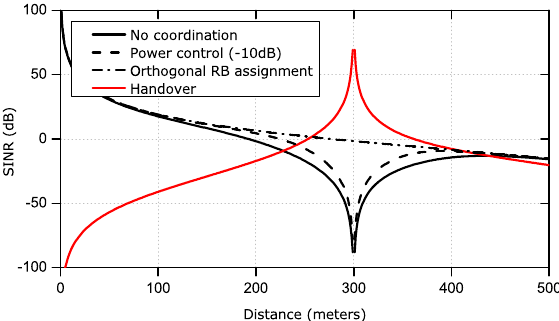
Figure 1. Achieved downlink (DL) signal-to-interference and noise ratio (SINR) of a macrocell user for different solutions in a three-tier hexagonal cellular network with cells of radius 500 m. Macro base stations (BSs) transmit with 10 W power while a femto BS at 300 m uses 0.1 W